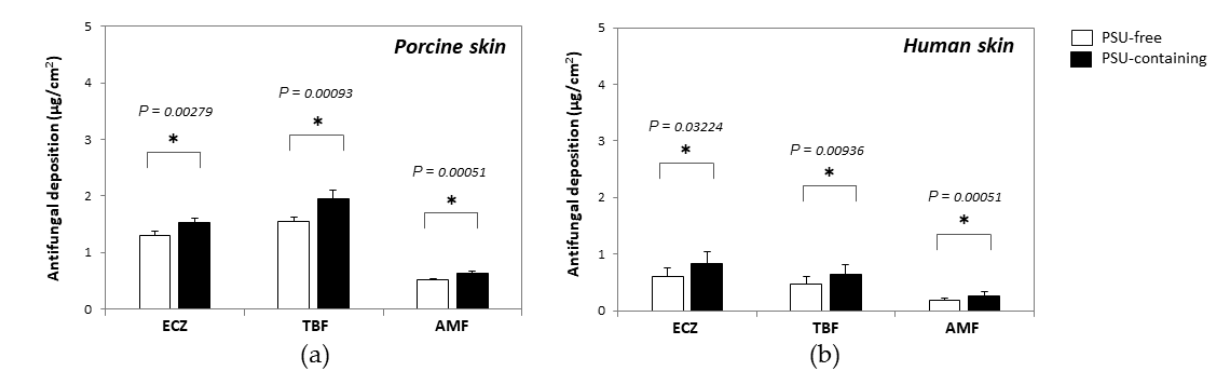
Figure 7. Comparison of antifungal deposition in PSU-free and PSU-containing biopsies: ( a ) porcine ear skin and ( b ) human abdominal skin (mean ± SD, n ≥ 5). Statistically significant differences are indicate by the p -value in each figure.